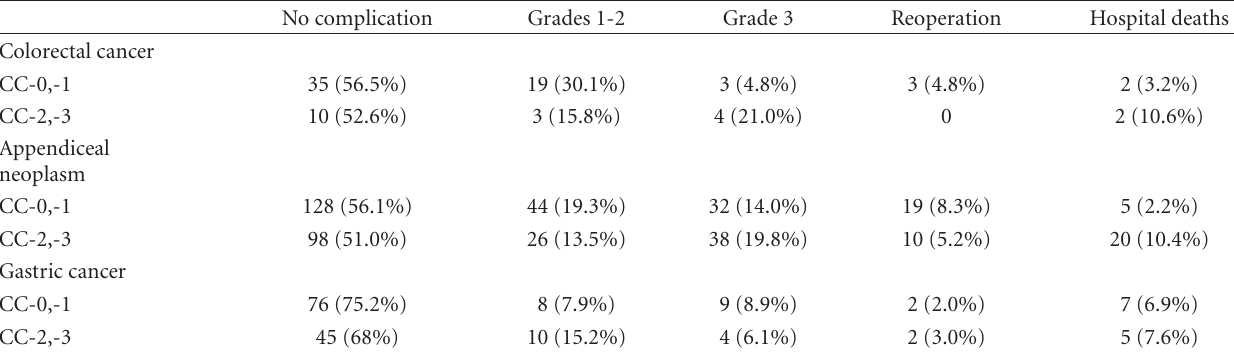
Table 3: Postoperative mortality and morbidity after cytoreductive